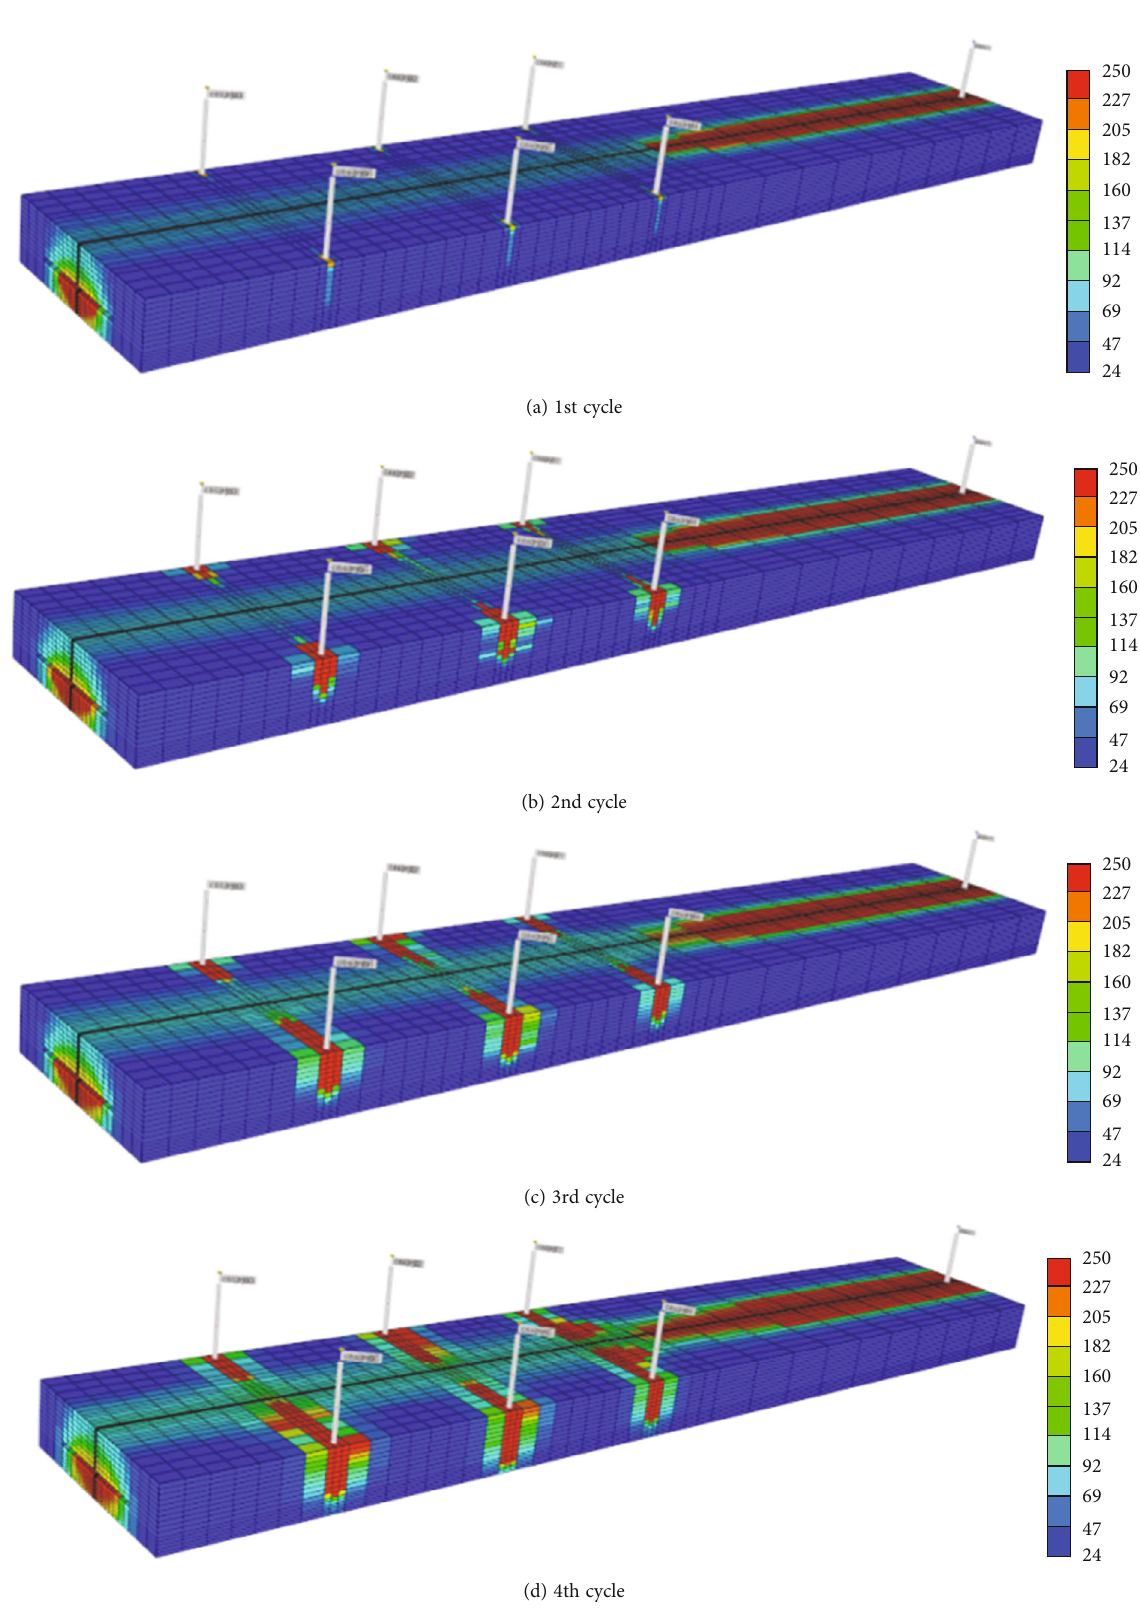
Figure 14: Temperature fi elds of di ff erent